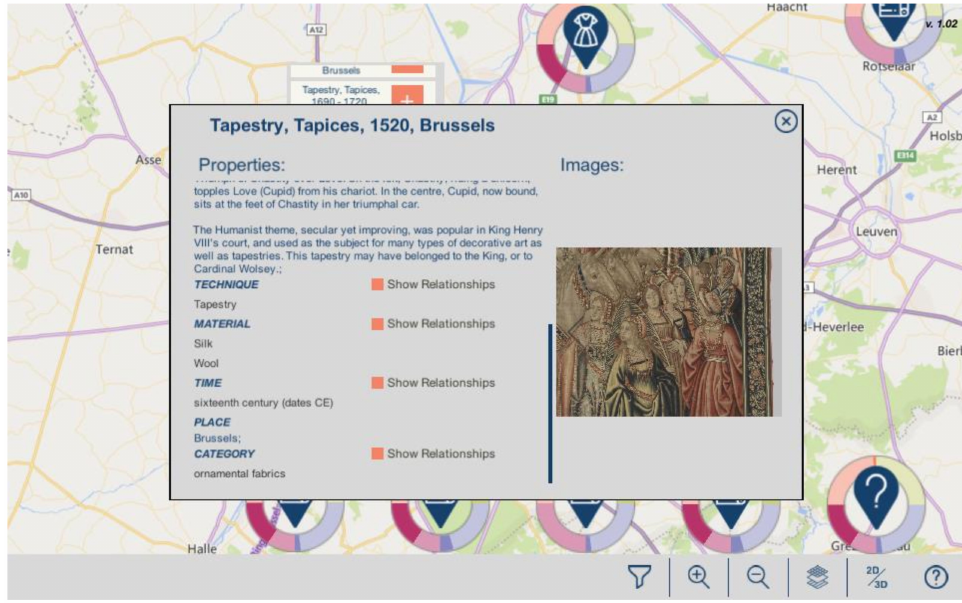
Figure 6. Information window of the properties of the objects in SILKNOW shown with